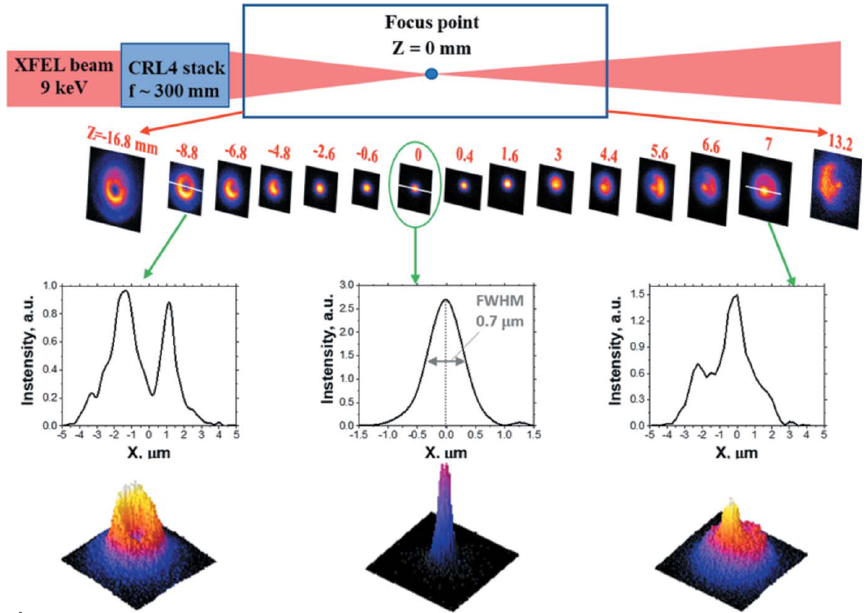
Figure 5 Schematic drawing of intensity distribution measurements of the XFEL beam near the focus position, and sequence of PL images, obtained in one XFEL shot on the surface of the LiF detector in different planes. Lower images are intensity profiles for Z -positions of (cid:2) 8.8 mm, 0 mm and 7